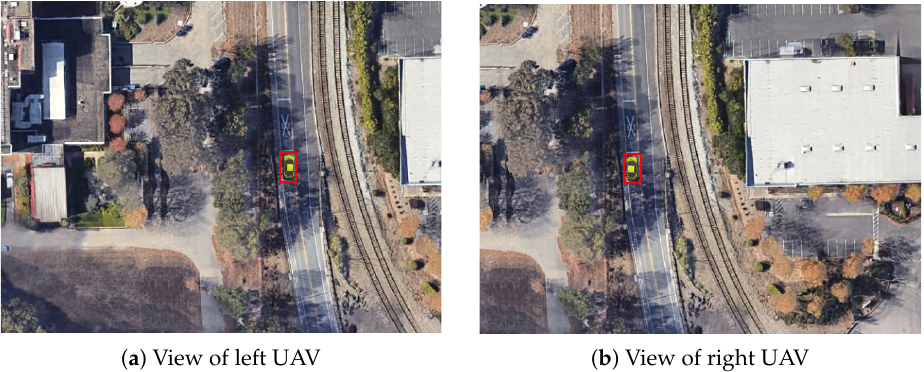
Figure 7. Two UAVs track and detect the moving target.